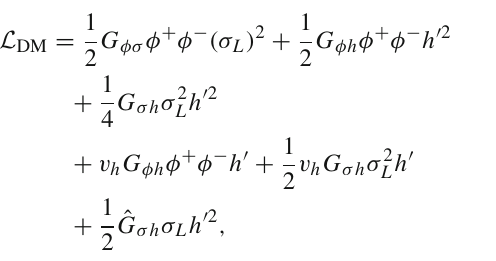
Fig. 1 One-loop diagrams contributing to the effective interactions among φ ± ,σ L and h (cid:6) , where the external momenta are set equal to zero where the canonical dimension of ξ ( a ) that of ξ